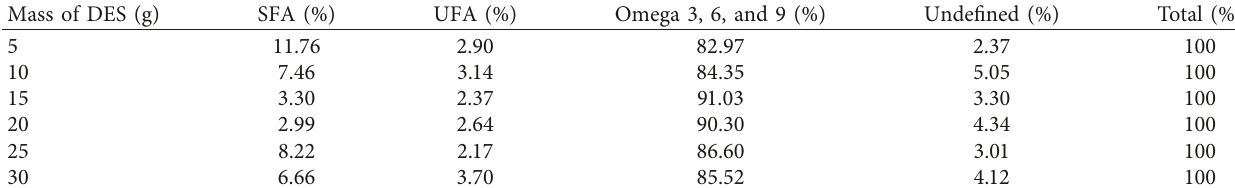
Table 7: Fatty acid compositions of the liquid